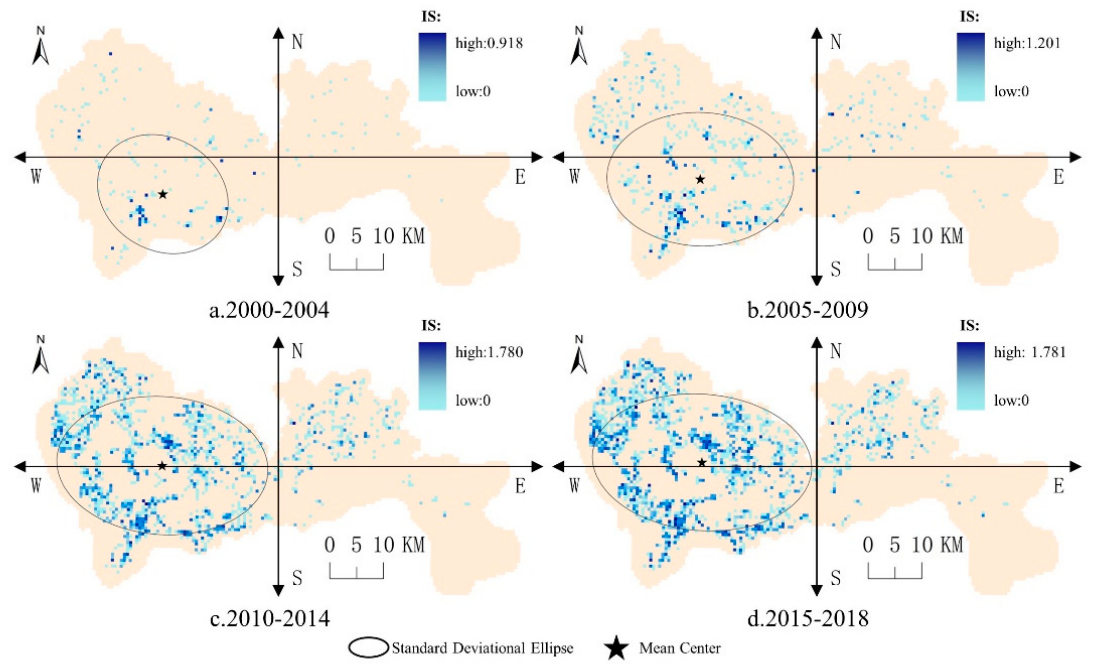
Figure 10. Spatial distribution of the innovation structure of the secondary industry in Shenzhen.